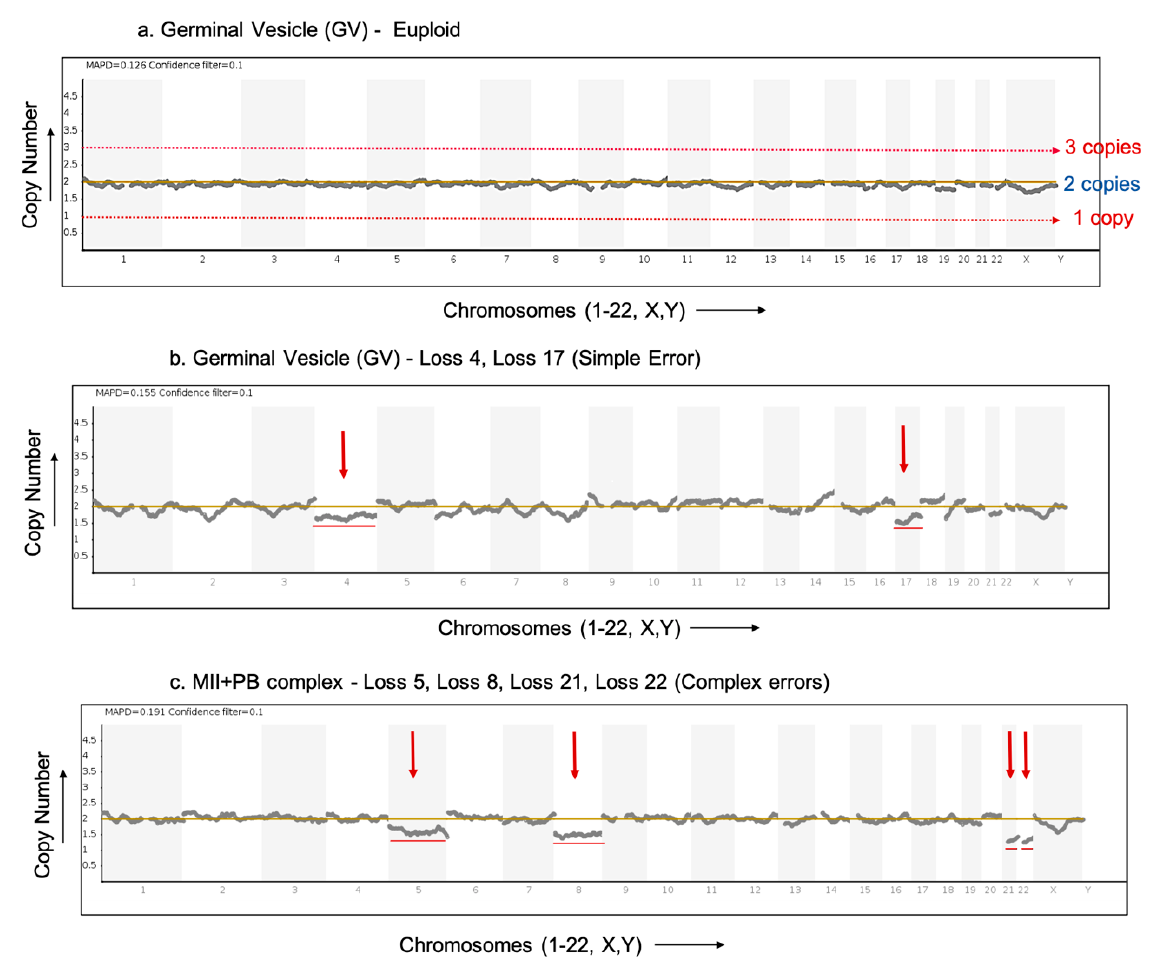
Figure 2. Result profiles of euploid and aneuploid oocytes analysed via NGS. The X -axis represents the chromosome number (Chromosome 1–22, X,Y). The Y -axis of the NGS graphs represents the chromosome copy numbers. ( a ) NGS pro- file of a euploid germinal vesicle (GV) stage oocyte with no loss or gain detected. ( b ) NGS profile of an aneuploid germinal vesicle (GV) stage oocyte (donor F) with red arrows indicating loss of chromosomes 4 and 17 (simple error). ( c ) NGS profile of an aneuploid MII+PB complex (donor D) (both cells analysed together in a single reaction) with red arrows indicating loss of chromosomes 5, 8, 21 and 22 (complex errors) .